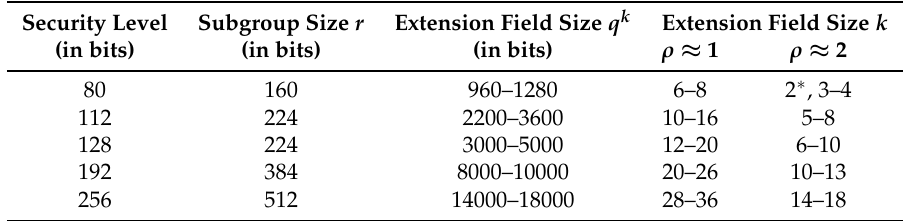
Table 1. Bit sizes of curve parameters and corresponding em-bedding degrees to obtain commonly desired levels of security [30].